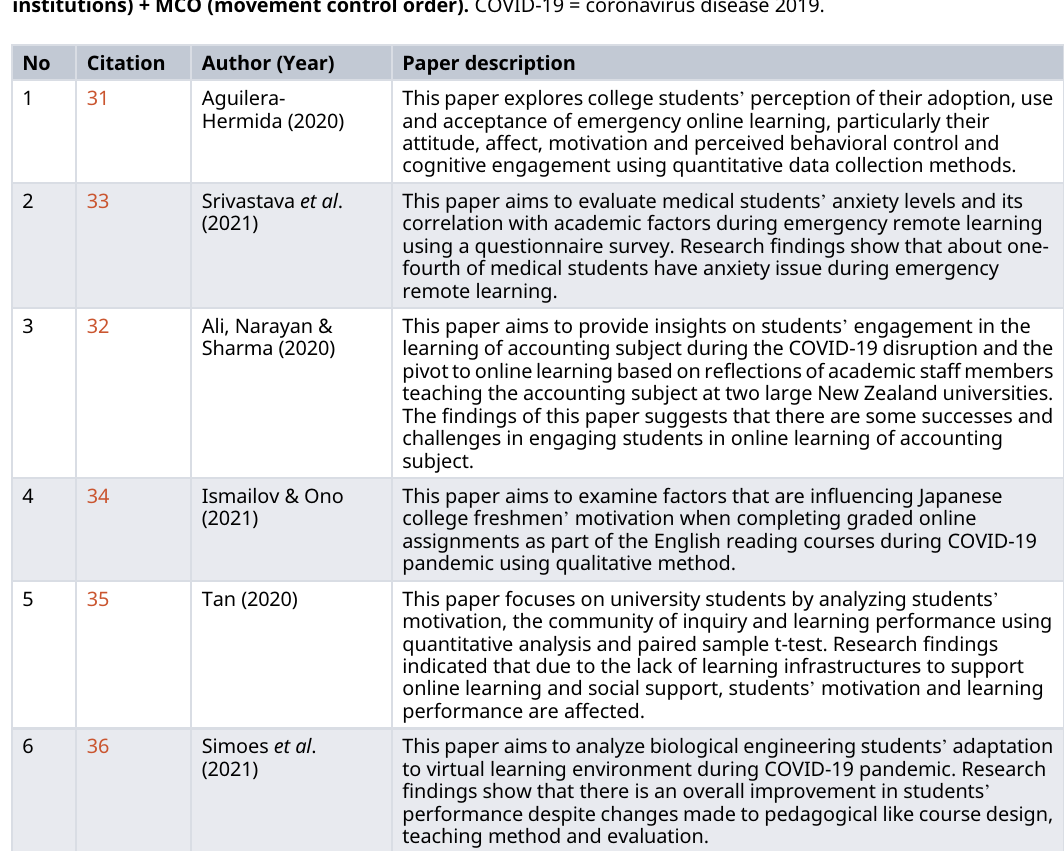
Table 7. Summary of six papers related to SOL (synchronous online learning) + HEI (higher education institutions) + MCO (movement control order). COVID-19 = coronavirus disease